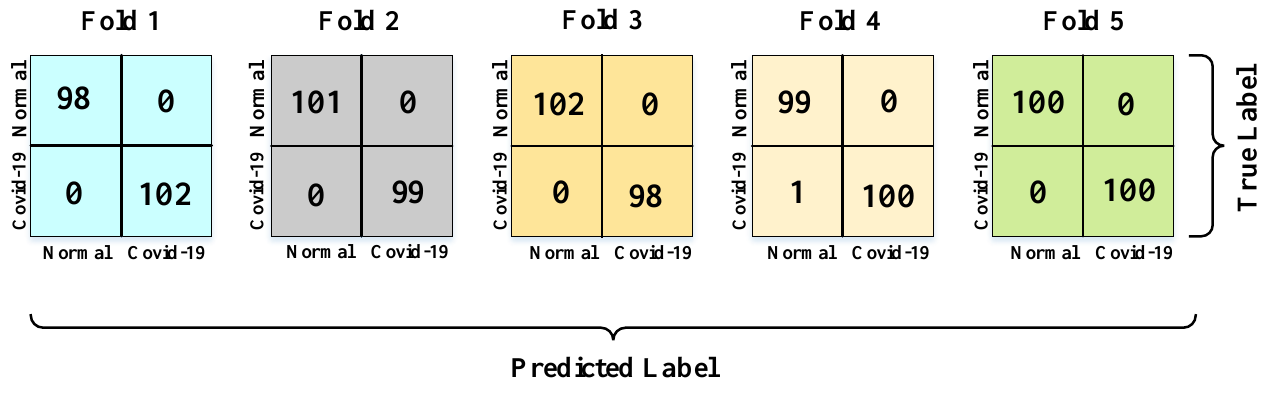
Figure 8. Confusion matrices for the 5-fold cross-validation training process.